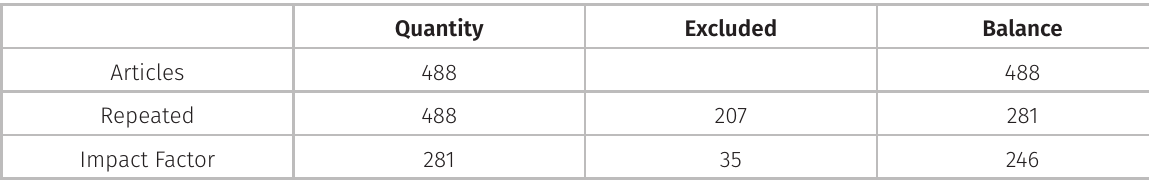
Table III. Filtering results of the sum of the articles of reviews 1 and